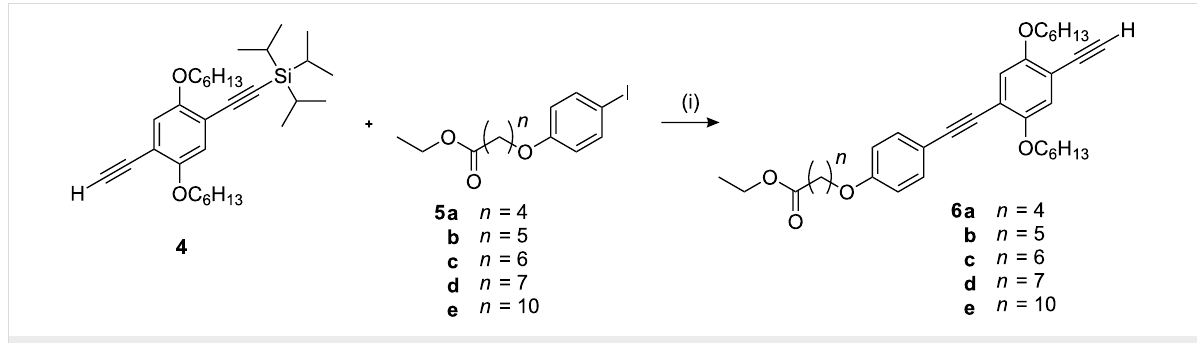
Scheme 1: Synthesis of arm derivatives 6 . Reaction conditions: (i) 1) Pd(PPh 3 ) 4 , CuI, piperidine, rt; 2) TBAF, THF,